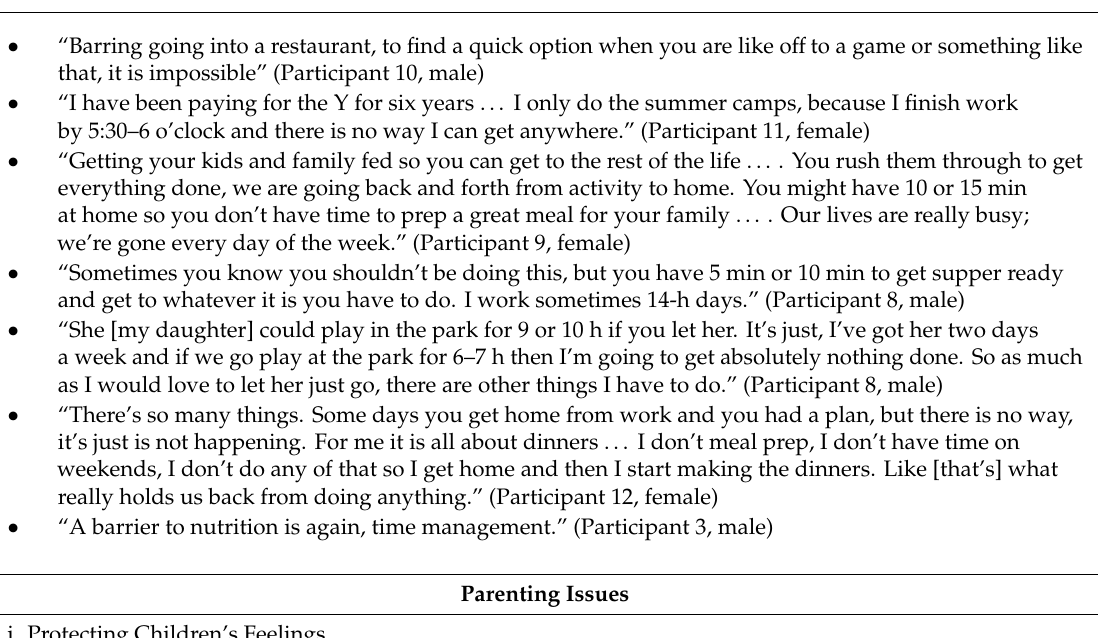
Table 5. Cont . Time